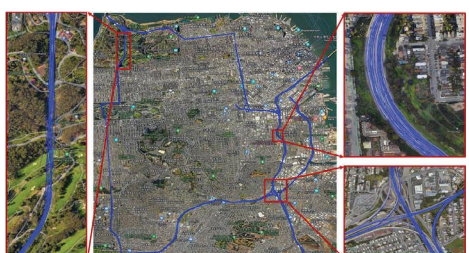
Figure 7: Lane centerline node